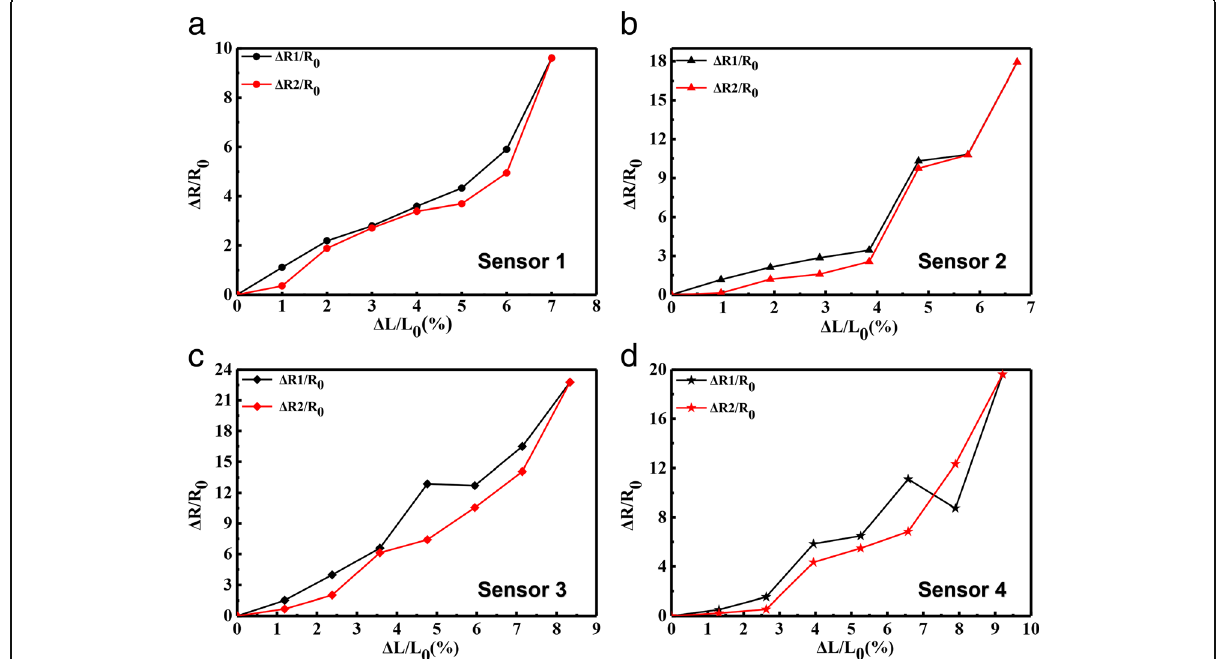
Fig. 5 The relative resistance changes of the sensors based on AgNWs & MNs in mass ratio of a 1:0, b 5:1, c 2:1, and d 1:1 with